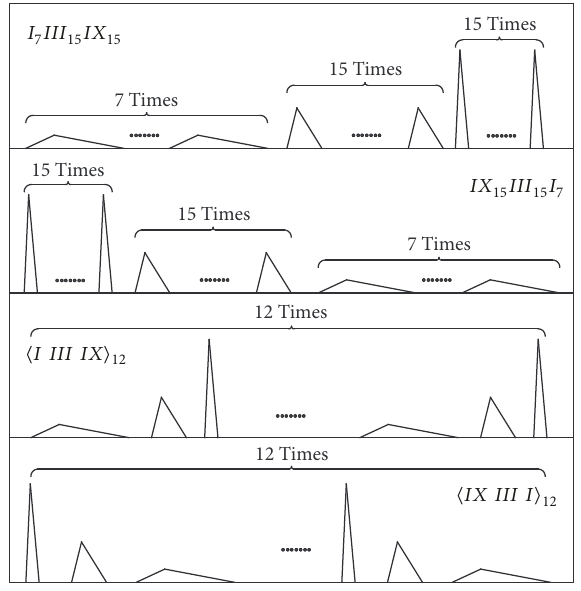
Figure 13: Four groups of pressure curves.